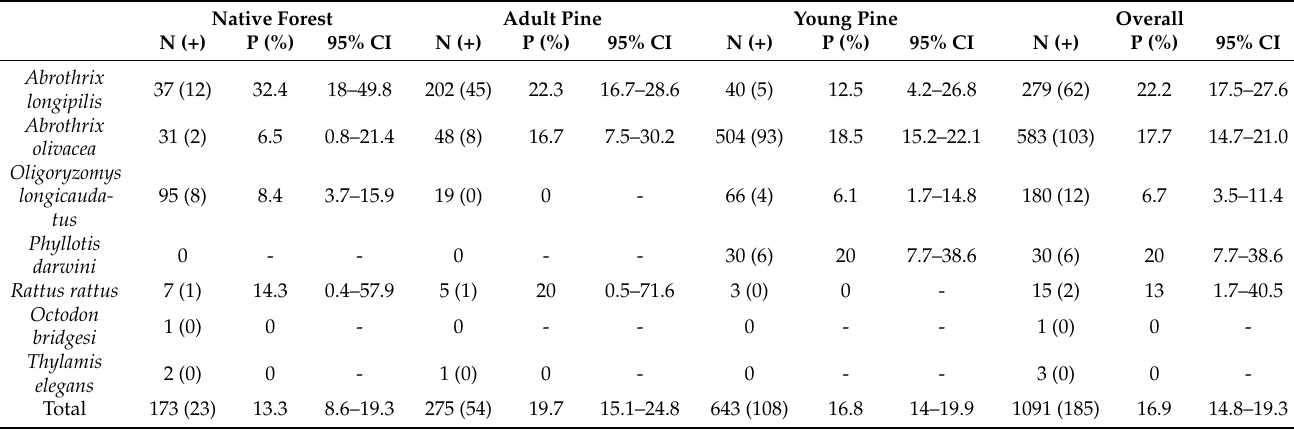
Table 2. Helminths in fecal samples of small mammals at three habitat types. Sample size (N), number of positive individuals (+), prevalence (P) and 95% confidence intervals (CI) are